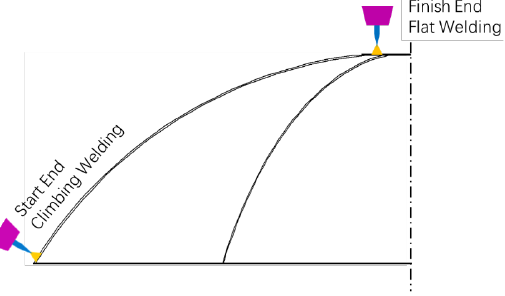
Figure 2. Two typical welding positions studied.